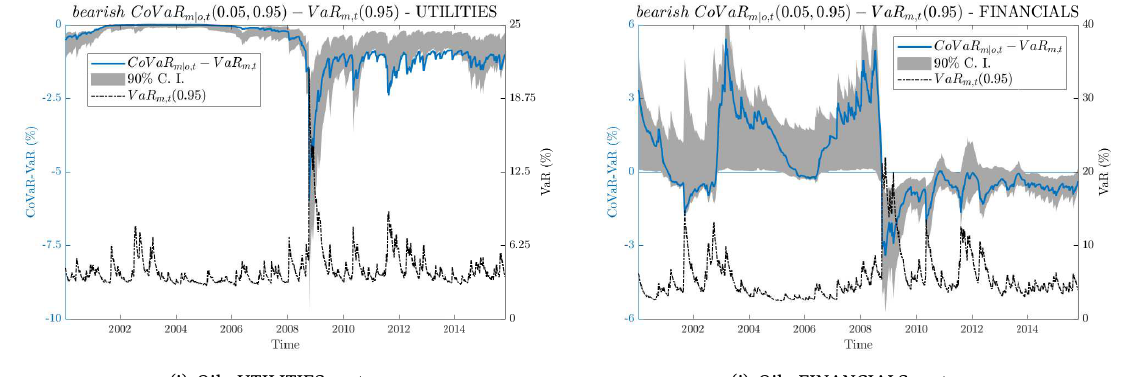
(i) Oil - UTILITIES sector (j) Oil - FINANCIALS sector